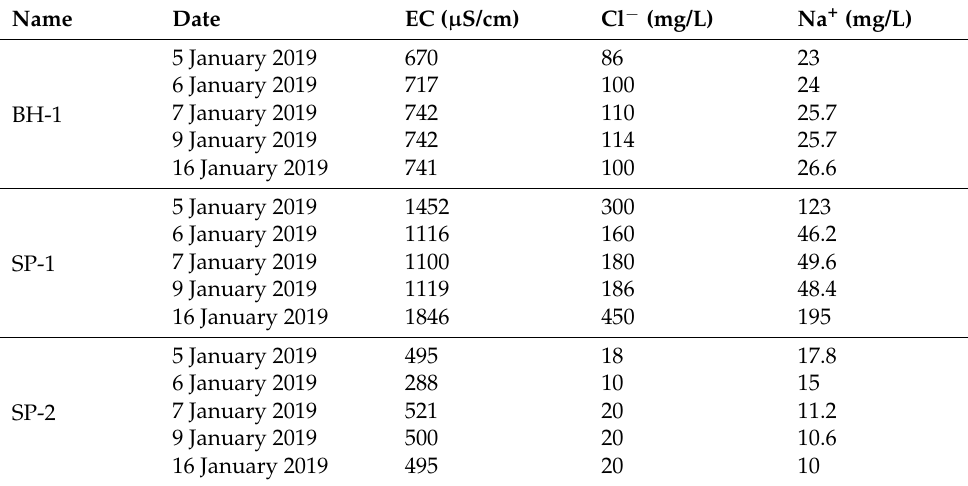
Table 1. Results from chemical analysis of the samples taken after a snowfall event and following a road-deicing campaign in